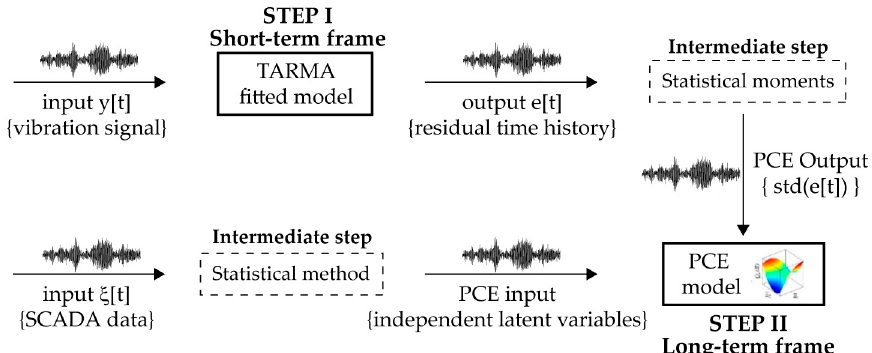
Figure 2. Steps of the proposed bi-component monitoring framework.